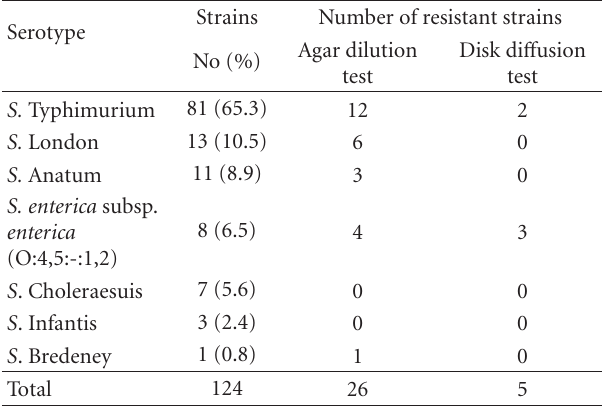
The values inside [] represent resistant strains. Table 3: Distribution of colistin resistant strains among di ff erent Salmonella enterica serotypes isolated from swine.